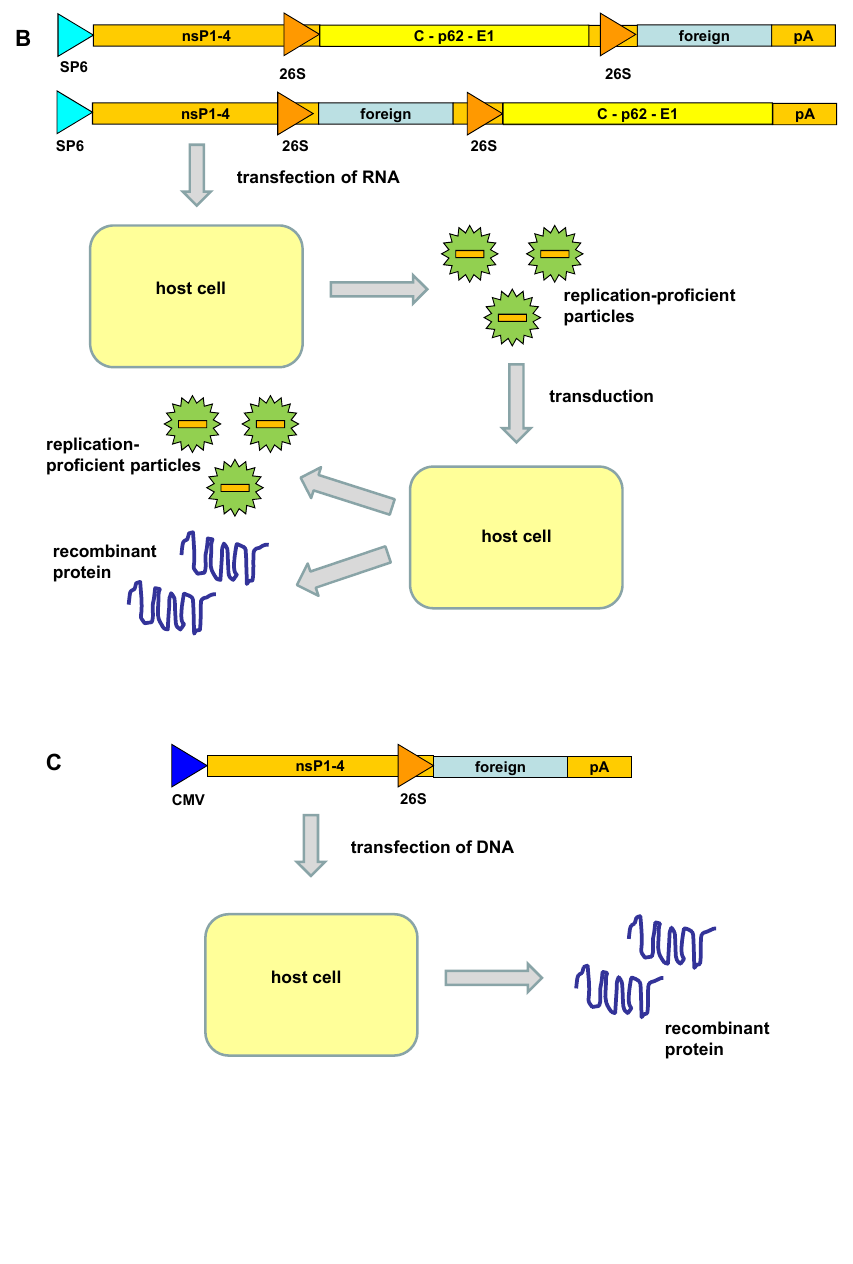
Figure 2. Alphavirus vector systems. ( A ) Replication-deficient recombinant virus particles: recombinant particles are generated by co-transfection of in vitro transcribed RNA from expression and helper vectors. The replication-deficient particles are capable of transduction of host cells resulting in high-level transient expression of recombinant protein. ( B ) Replication-proficient recombinant virus particles: transfection of RNA including the full-length alphavirus genome and the gene of interest generates replication-proficient particles capable of recombinant protein expression and simultaneous virus production after transduction of host cells. ( C ) Layered DNA/RNA vectors: transfection of vector DNA provides transient expression of recombinant